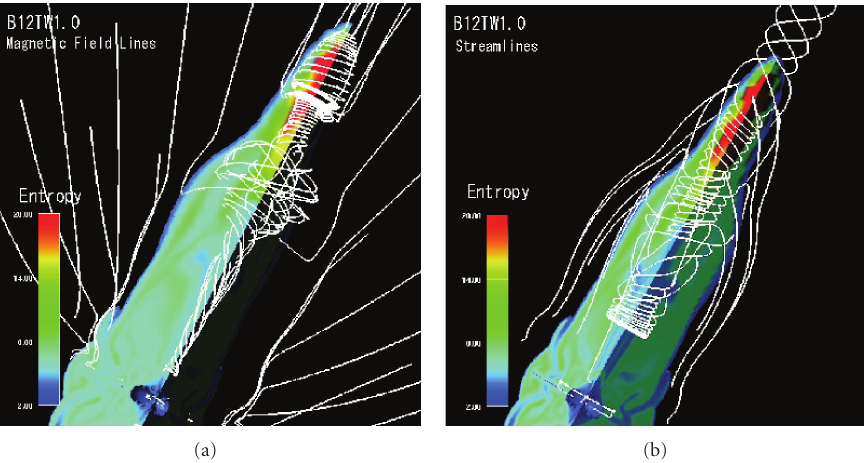
Figure 17: Three-dimensional plots of entropy with the magnetic field lines (a) and the streamlines of the matter (b) during the jet propagation at 20ms and 94ms after bounce, respectively (for model B12TW1 taken from [268]). The outer edge of the sphere colored by blue represents the radius of 7 . 5 × 10 7 cm. These panels highlight not only the wound-up magnetic field around the rotational axis (a), but also the fallback of the matter from the jet head of the downwards to the equator, making a cocoon-like structure behind the jet (b).